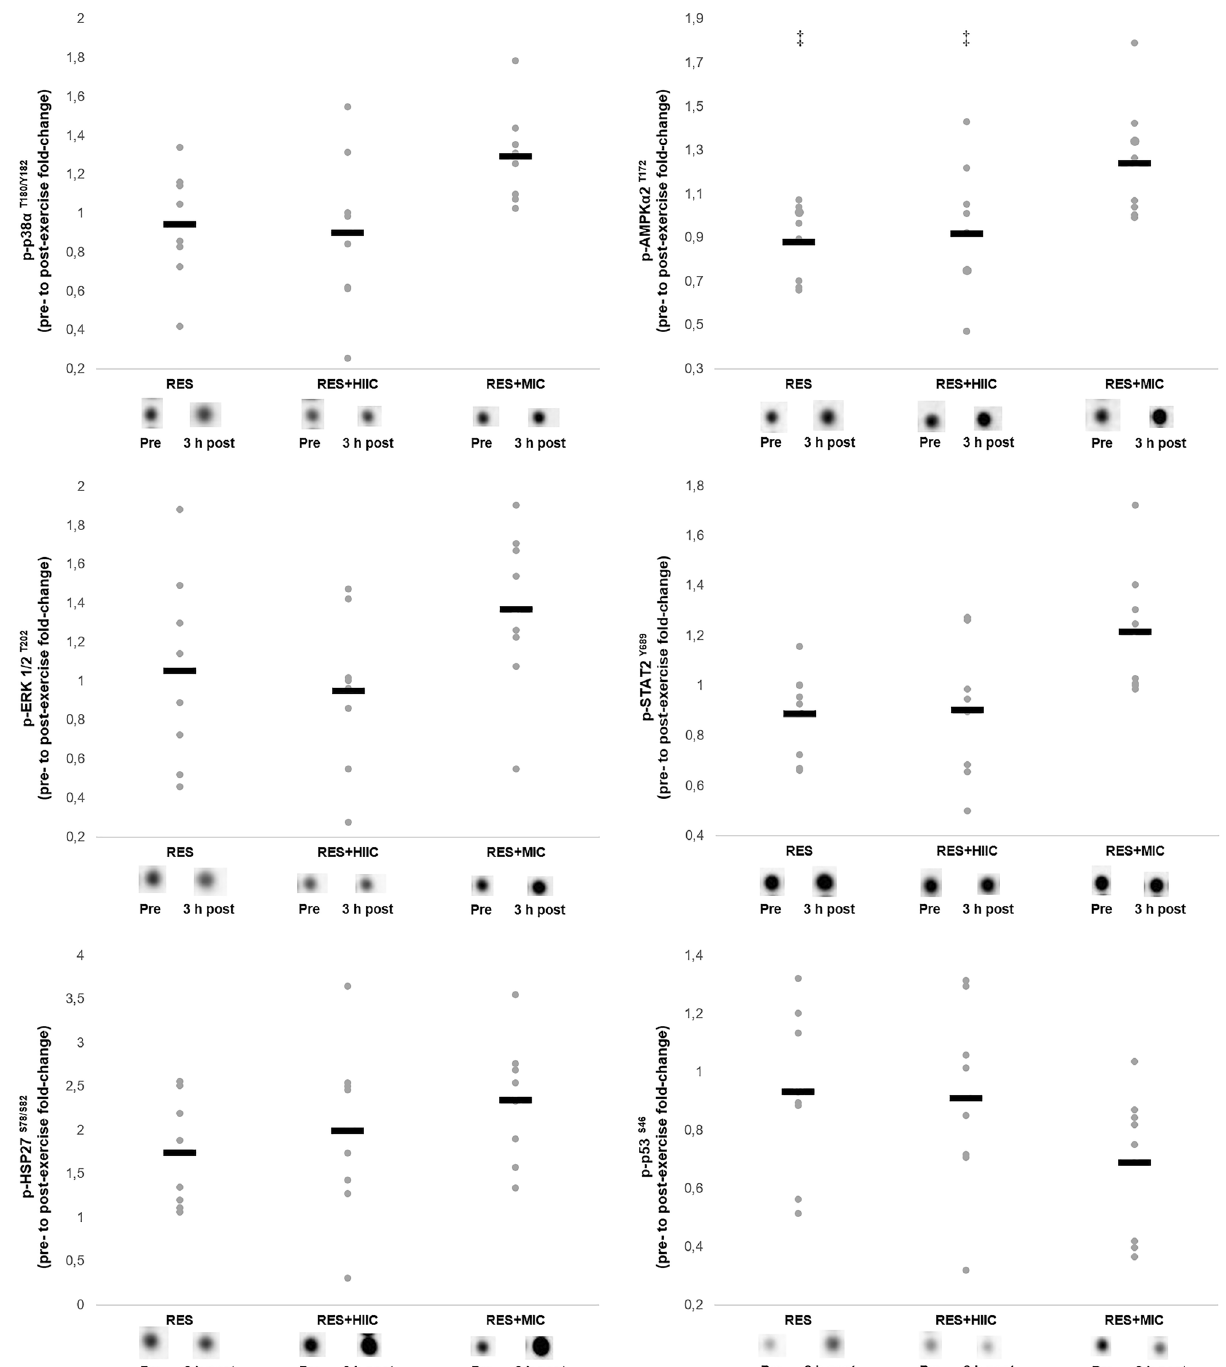
Figure 1. Individual and mean responses in phosphorylation of the AMPK signaling pathway in the RES, RES + MIC, and RES + HIIC conditions including representative images. Grey dots represent individual responses and black lines represent the mean. ‡, significantly different from RES + MIC condition ( p < 0.05). In all instances all samples from 8 participants were available for